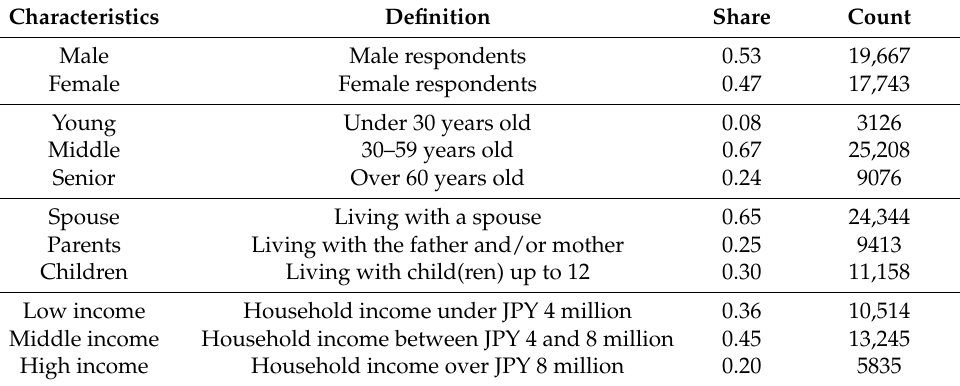
Table 1. Structure of